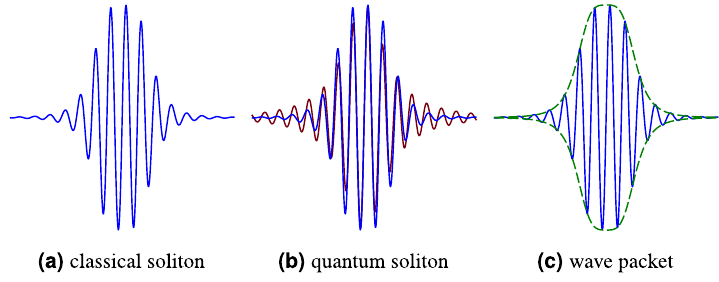
Figure 1. A comparison between soliton, quantum soliton and wave packet.